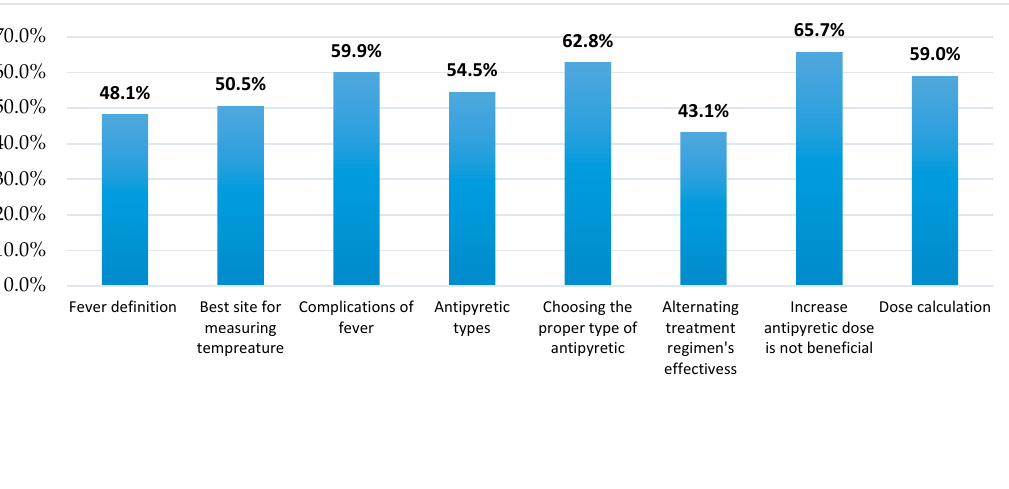
Table 1. Sociodemographic characteristics of mothers and their knowledge and management prac- tices of preschool childhood fever.